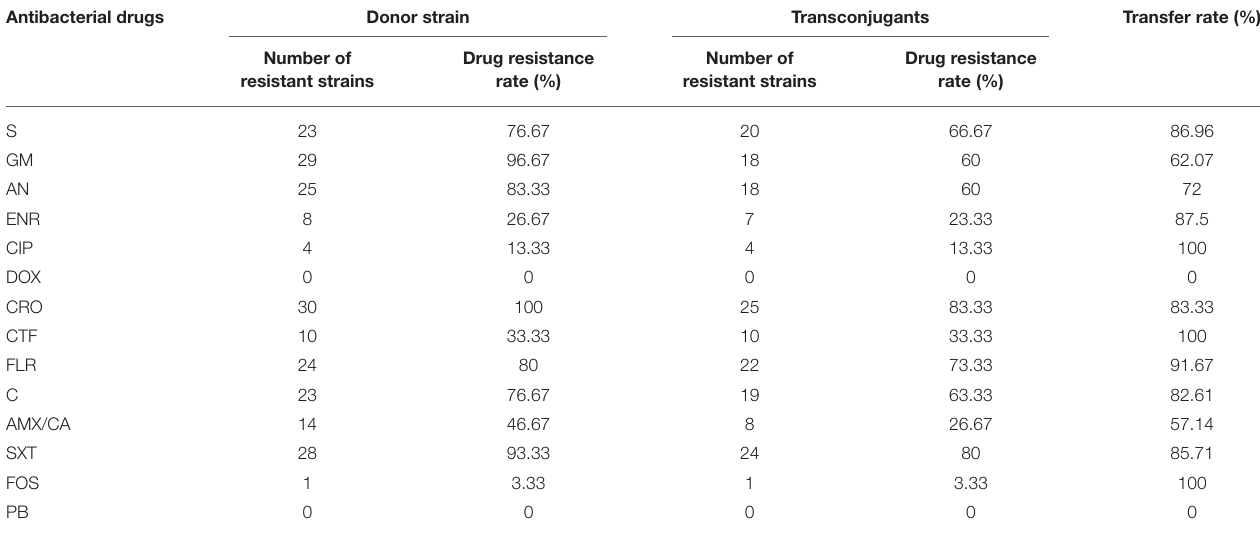
TABLE 7 | The resistance rate of donor isolates and transconjugants to 14 antibiotics. Antibacterial drugs